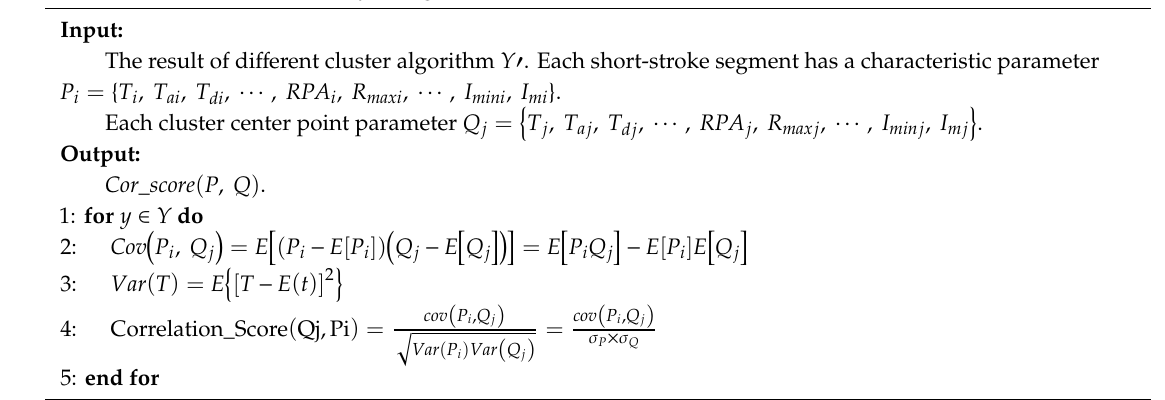
Algorithm 2: Correlation analyze